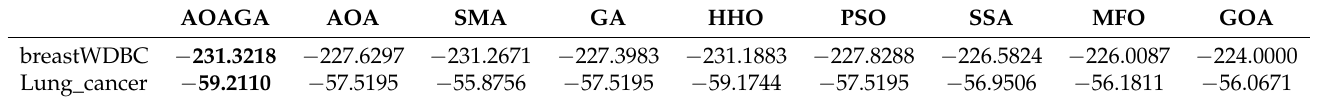
Table 13. Real Application: Maximum of the fitness value.